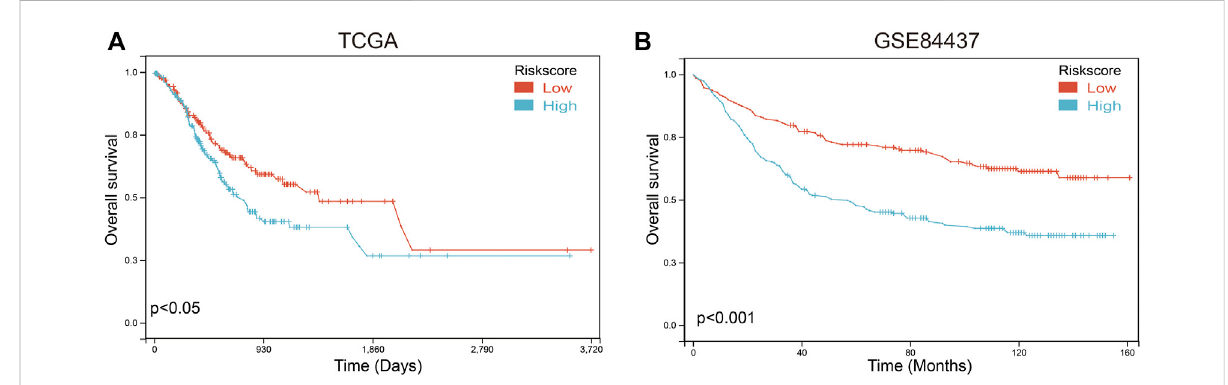
FIGURE 10 Validation of the prognosis risk model The prognosis risk model was validated using TCGA (A) and GSE84437 (B)